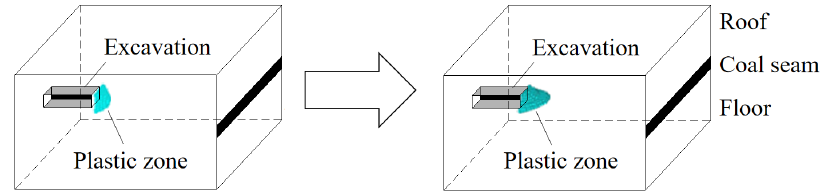
Figure 7. The expansionary evolution of the plastic zone in event II.